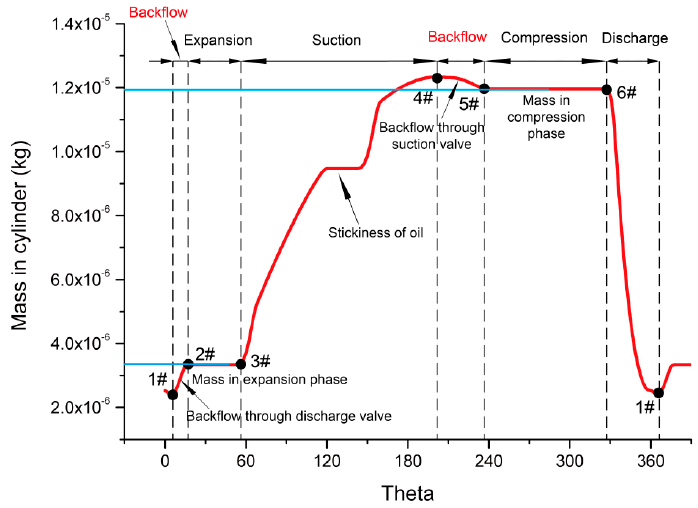
Figure 6. Details of the m- θ diagram.